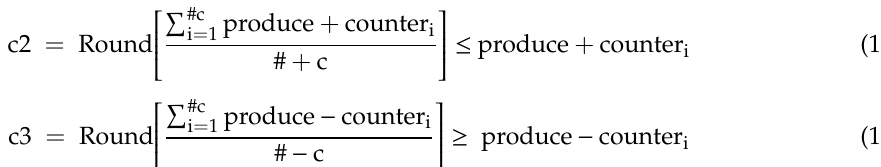
Table 4 calculates c1, c2 and c3.